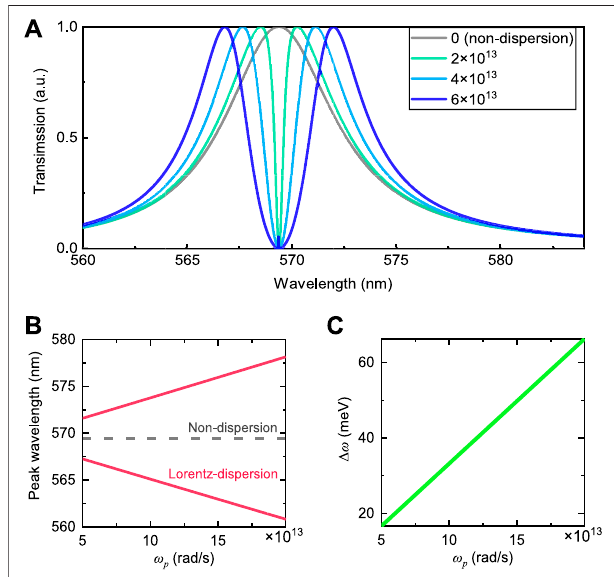
FIGURE 3 | Transmission spectral splitting in various magnitudes of atom plasma frequency ω p . (A) Evolution of the transmission spectral pro fi les from the single-peak pro fi le at ω p (cid:1) 0 to the two-peak pro fi le with increased splitting when ω p becomes larger and larger from 2 × 1013 to 6 × 1013 rad/s. (B) The position of two split transmission peaks showing the two peaks in Lorentz-dispersion (red solid line) gradually depart from each other obviously from the single peak in non-dispersion case (gray dotted line) as the increase of the plasma frequency ω p from 5 × 1013 to 2 × 1014 rad/s with 1,000 points sampled. (C) The splitting magnitude Δω increases as the plasma frequency ω p increases. In the interval the splitting Δω can reach up to 66.3 meV at the center wavelength of 569.4 nm.